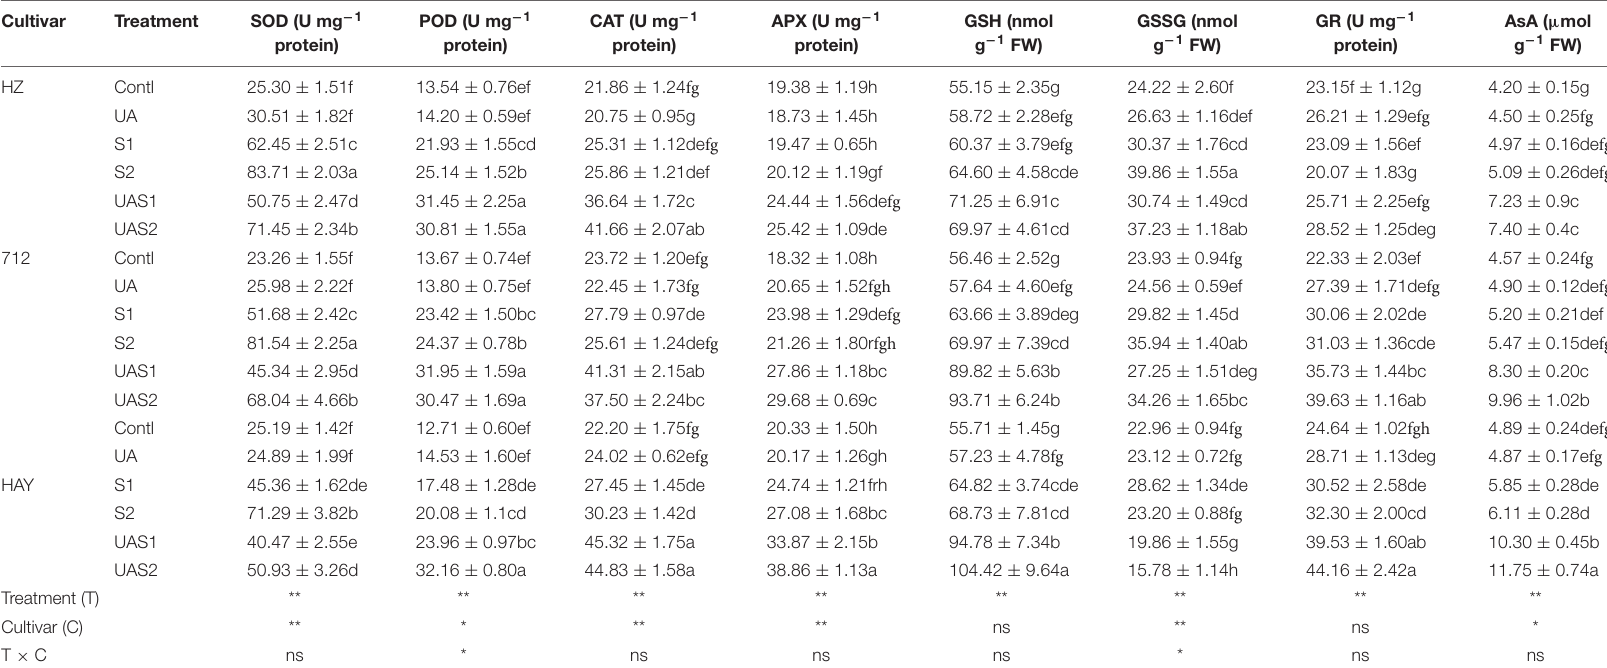
Data are the means of five replicates ± SE, and three/four plants were bulked for each replicate. Values followed by the different letters indicate significant differences based on two-way ANOVA followed by Duncan’s test (p < 0.05) for each cultivar at different saline stress treatments. *p < 0.05; **p < 0.01 level; ns, non-significant. Contl, control; UA-, ursolic acid. S1, 4 dS m − 1 ; S2, 8 dS m − 1 ; UAS1, Ursolic acid + 4 dS m − 1 ; UAS2, Ursolic acid + 8 dS m − 1